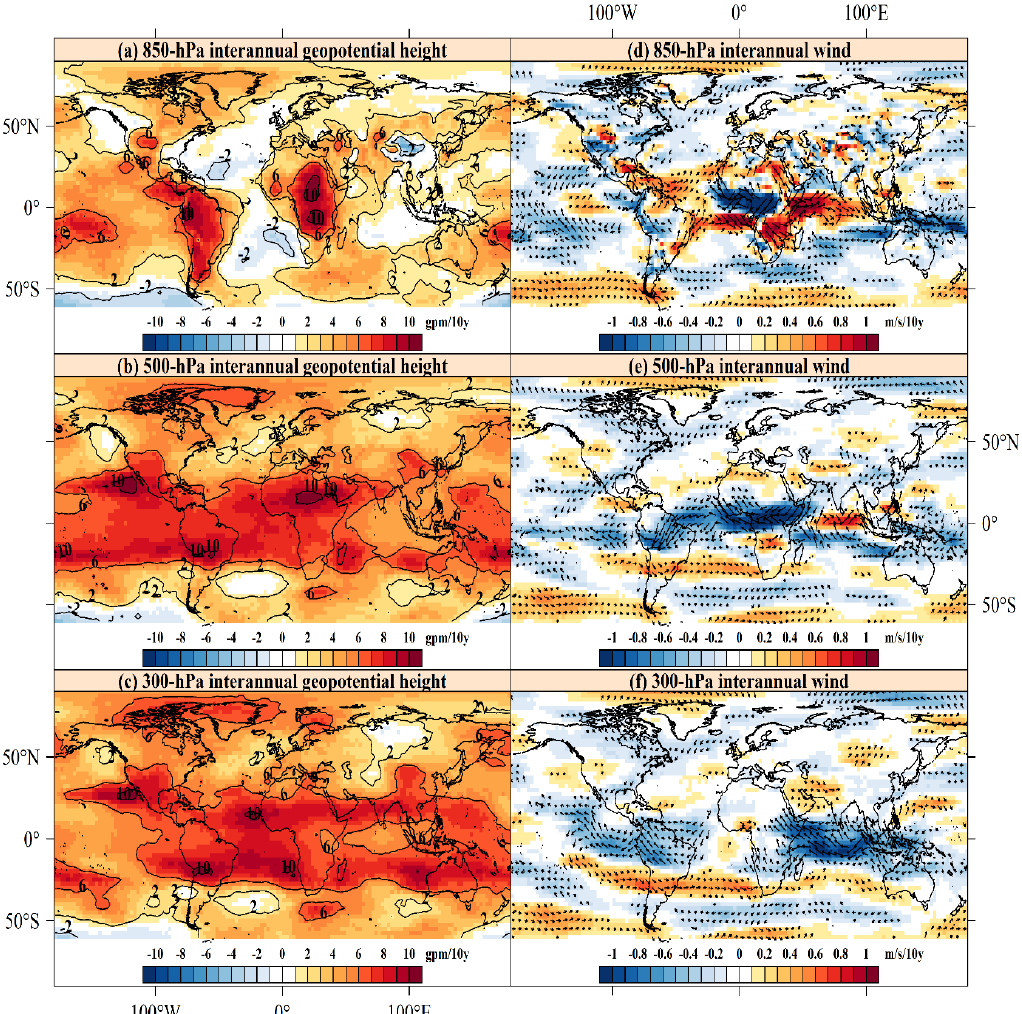
Figure 3. Spatial patterns of annual trends in atmospheric circulation. Trends in ( a – c ) geopotential height and ( d – f ) horizontal wind at 850 (top), 500 (middle), 300 (bottom) hPa based on the Mann - Kendall test. The red (blue) shades indicate the positive (negative) trends at the 0.05 level. The arrow represents the direction of the horizontal wind and its length represents the magnitude of significance. Blank areas indicate that the trend is not significant.